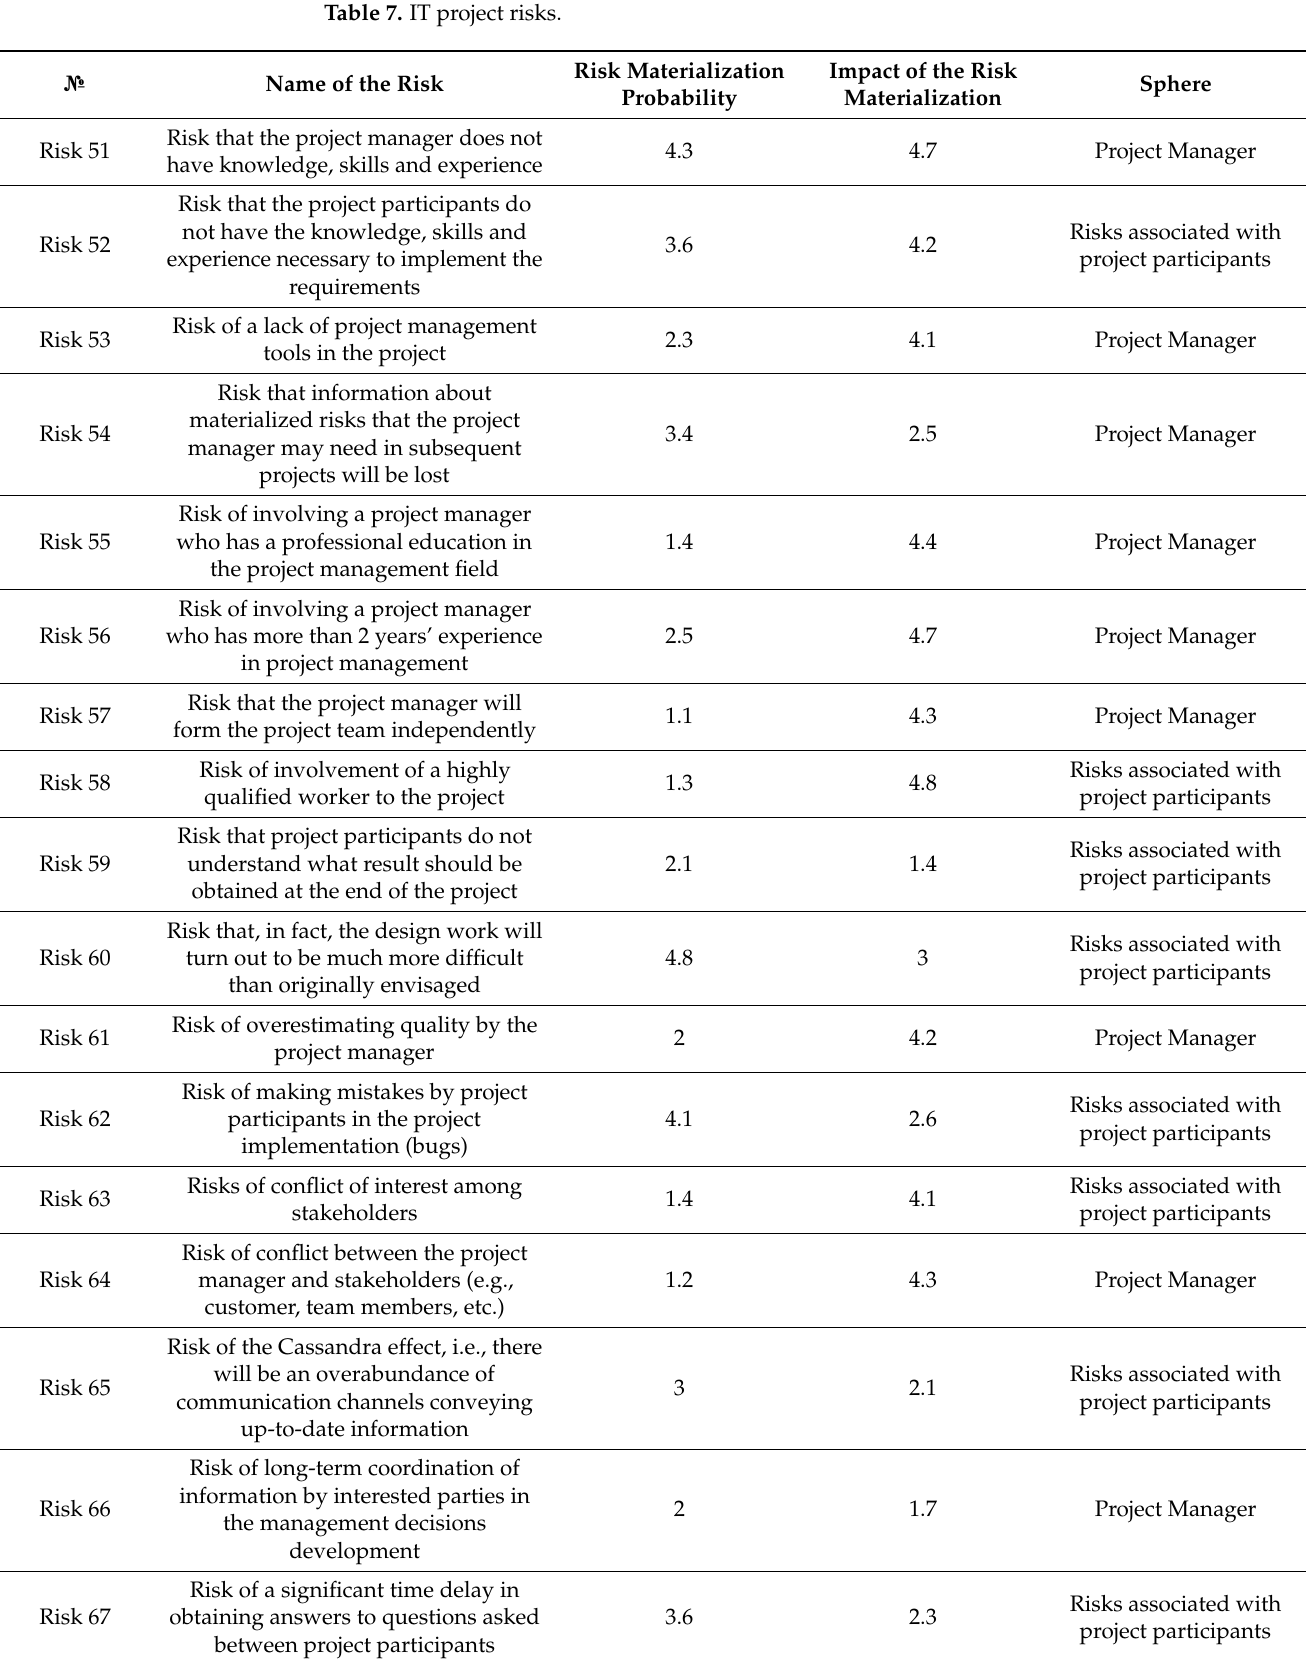
Table 7. IT project